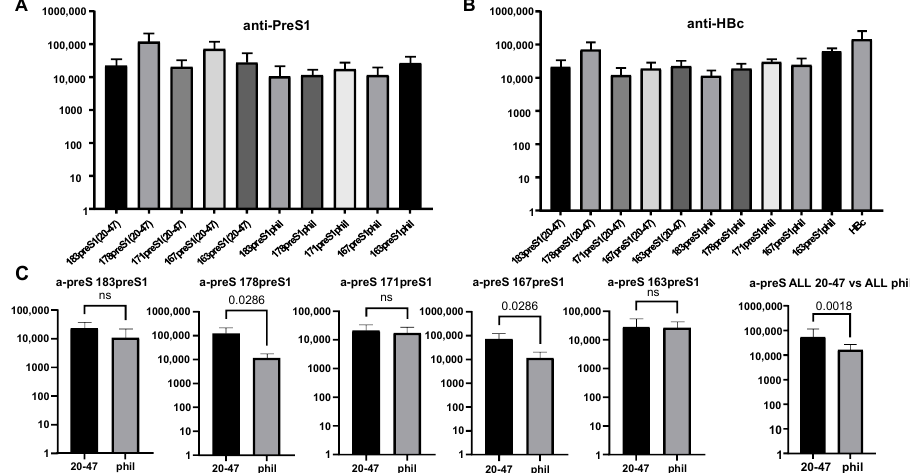
Figure 10. Immunogenicity of HBc-preS1 proteins. BALB/c mice were immunized with VLPs of HBc-preS1 proteins shown under bars in ( A , B ). ( A ) Anti-preS1 response and ( B ) anti-HBc response. ( C ) Statistical analysis of antibody response (Mann–Whitney U test). The type of HBc vector (with